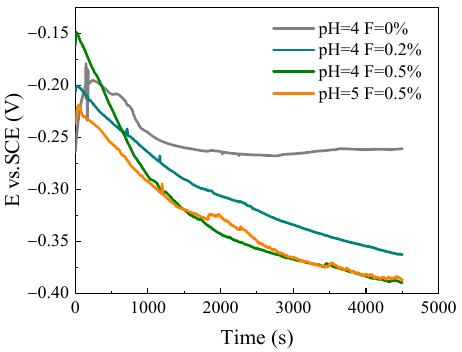
Figure 4. OCP diagram of the SLM alloy in ASS with different pH and F −